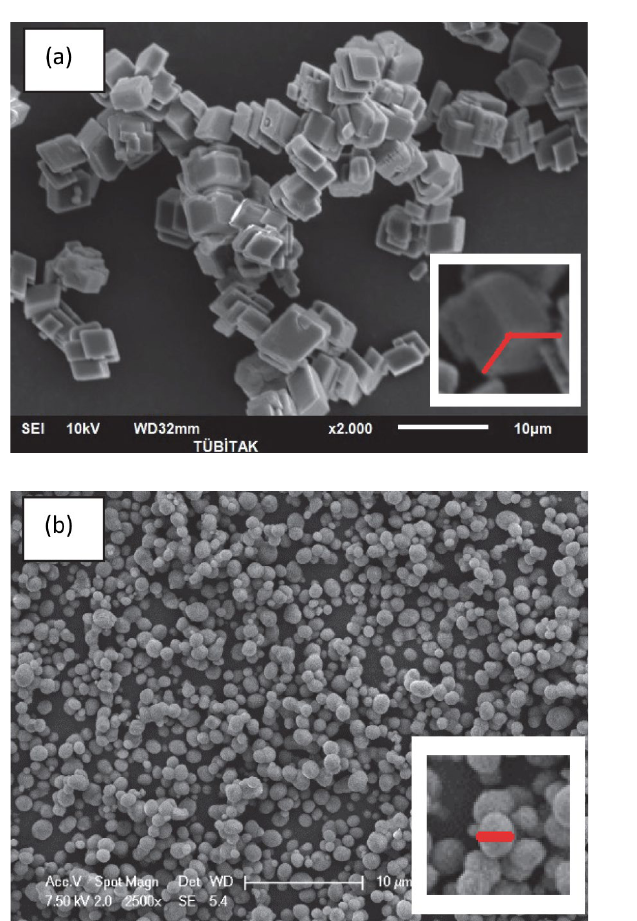
Figure 3. SEM photographs of CaCO 3 obtained in the (a) ab- sence of additive and (b) presence of PVS.